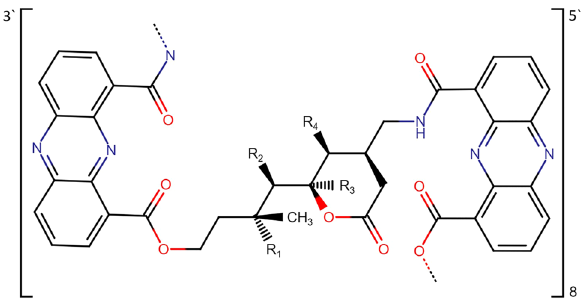
Figure 2. General 3D structure of HASDI. It consists of elementary blocks. Each block consists of a branched linker, where R 1 , R 2 , R 3 and R 4 are radicals that directly recognize the sequence of base pairs and two phenazine rings intercalating between every two nucleobase pairs. HASDI includes eight such blocks for recognition of 16 base